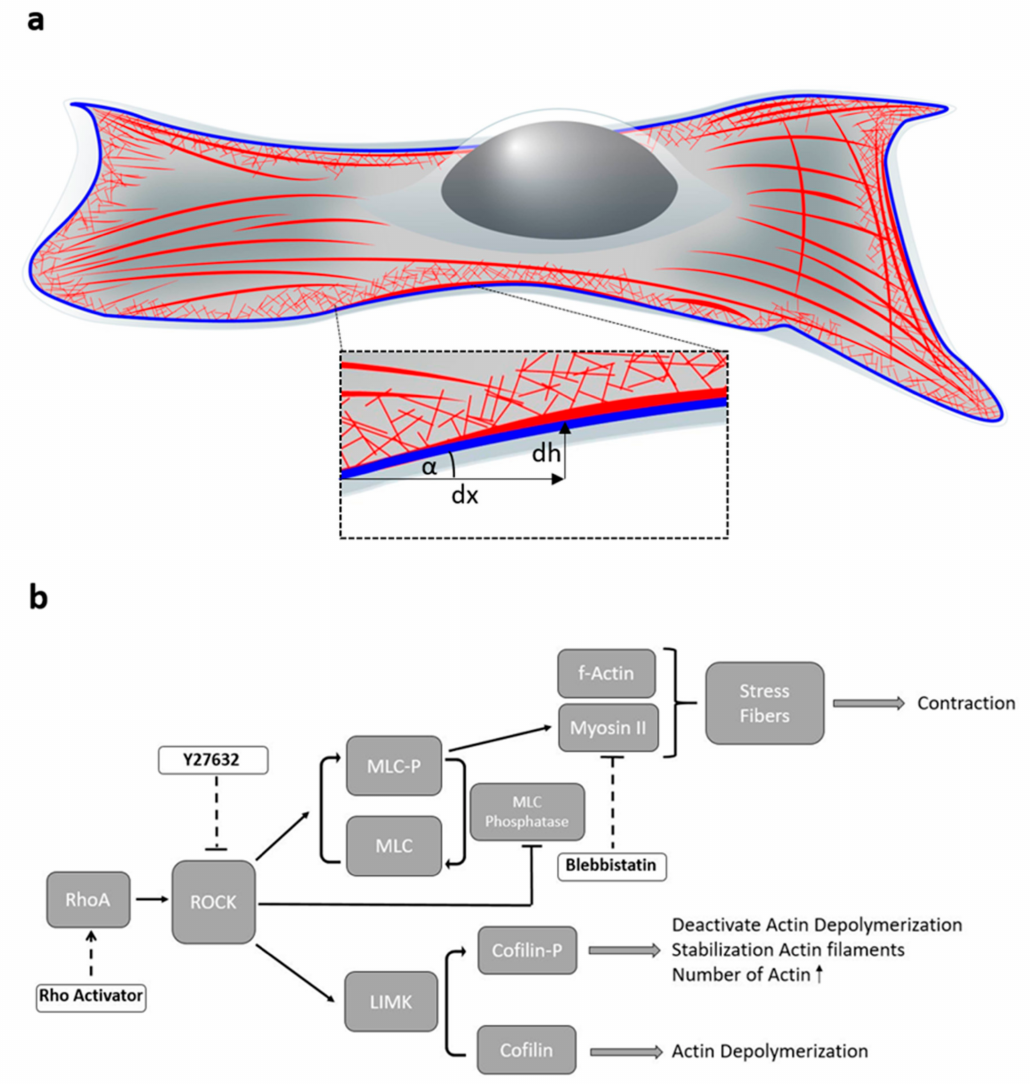
Figure 1. ( a ) Scheme of a cell with actin cytoskeleton (red) and nucleus (grey) shown in 3D. The further analyzed actin edge consists of different types of actin and is shown in blue. The image section shows the parameter angle along the edge, which describes the differentiation of the edge. ( b ) Schematic of the investigated ROCK Pathway and the influence of certain drugs on key points in the pathway. RhoA activates the Rho-associated coiled coil-containing protein kinase (ROCK). ROCK catalyzes the phosphorylation of the myosin light chain (MLC) to myosin light chain phosphate (MLC-P) and inhibits myosin light chain phosphatase (positive feedback loop). This increases the binding of myosin II to actin and thus the contractility of the cell increases. ROCK phosphorylates LIM kinase (LIMK). This phosphorylates cofilin. The existing actin filaments stabilize and increase as actin depolymerization is deactivated. Rho activator enhances the action of RhoA, Y27632